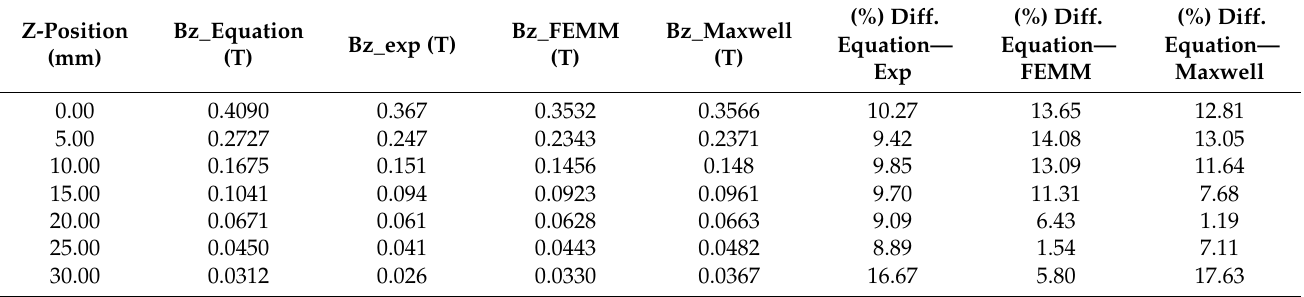
Table 5. B-field values at a different position from the magnet surface and the percentage differ- ences between analytical values and values obtained experimentally and by numerical analysis for neodymium N52-type permanent magnet.